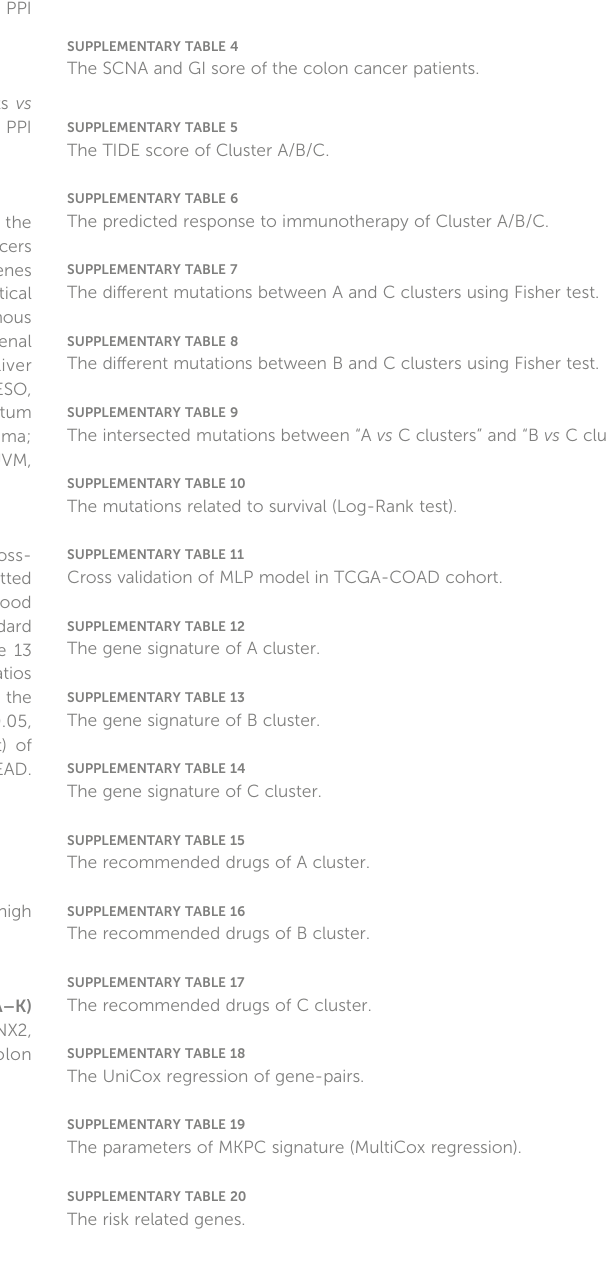
SUPPLEMENTARY TABLE 4 The SCNA and GI sore of the colon cancer patients.